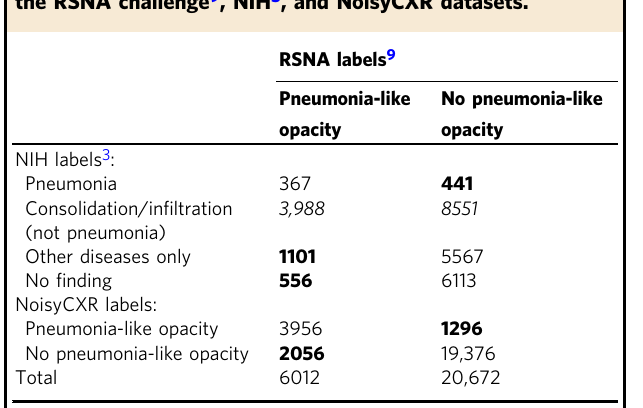
Thedisagreementsbetweentwolabelsetsarehighlightedinboldfont.Fieldsinitalicindicatean unclear agreement between both sets of labels. NoisyCXR labels are collected from the original NIH labels where possible, and the remainder are uniformly sampled (10%) from the “ Consolidation/in fi ltration ” category to increase the noise rate further in the